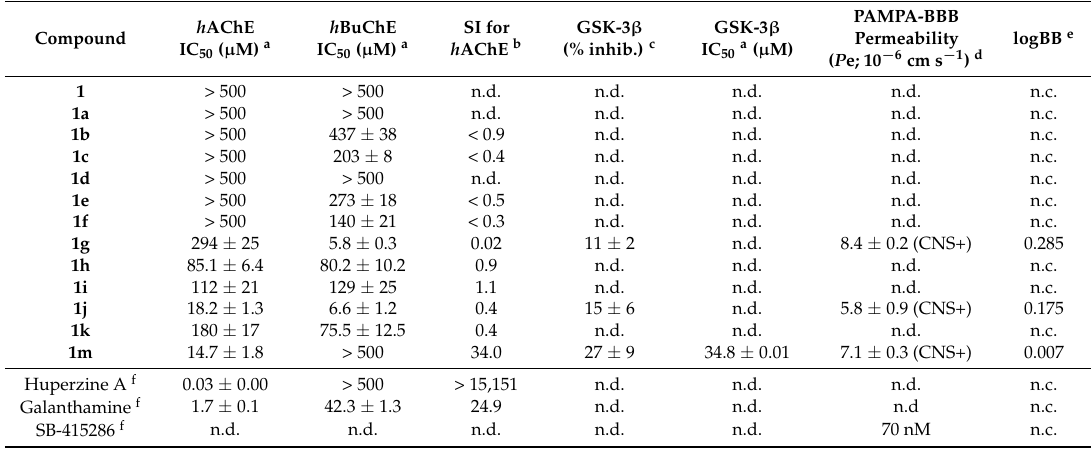
Table 1. Results of biological activities connected to AD of haemanthamine derivatives ( 1a – 1m ).